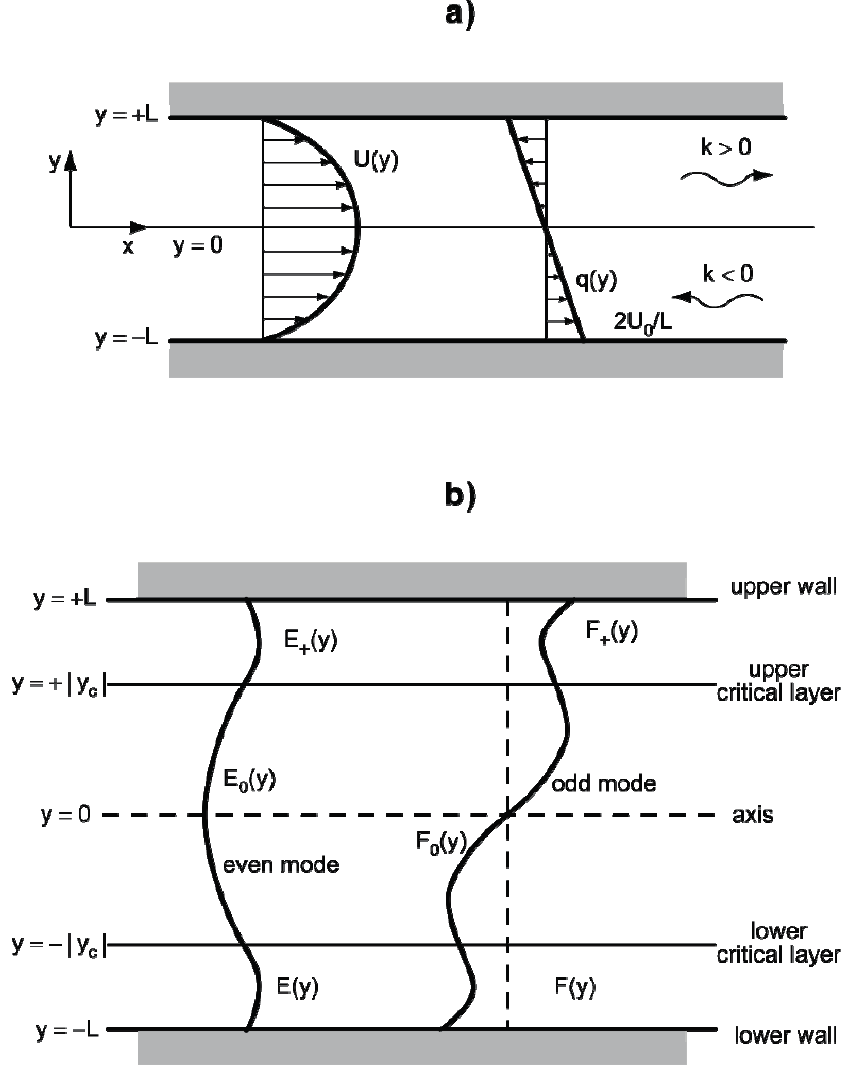
Figure 2. Shear-acoustic waves in a fan inlet duct. The mean flow in a duct, like an engine inlet, is sheared ( a ) because the velocity must zero at the wall. Thus the waves are acoustic-shear waves, that is acoustic-vortical coupling is particularly important in the boundary layers. There is a critical layer where the Doppler shifted frequency vanishes, that is where the horizontal phase speed equals the mean flow velocity. At the critical layer the waves exchange energy with the flow, and may be absorbed, amplified, reflected or transformed into another mode. In the case of a symmetric sheared mean flow in a duct [203] the waves are predominantly acoustic near the axis (no shear) and transform across the critical layers to predominantly vortical near the walls (maximum shear). Since the location of the critical layers depends on the phase speed (or frequency) of the wave this leads to a continuous spectrum specified by the wave equation in the duct in addition to the discrete spectrum due to the wall boundary conditions. The discrete spectrum consists of 3 sets of modes one set for each region separated by the critical layers, that is: (i) two sets between the walls and the nearest critical layers; (ii) a third set between the critical layers. For symmetric boundary conditions the acoustic field can be split in even and odd modes relative to the